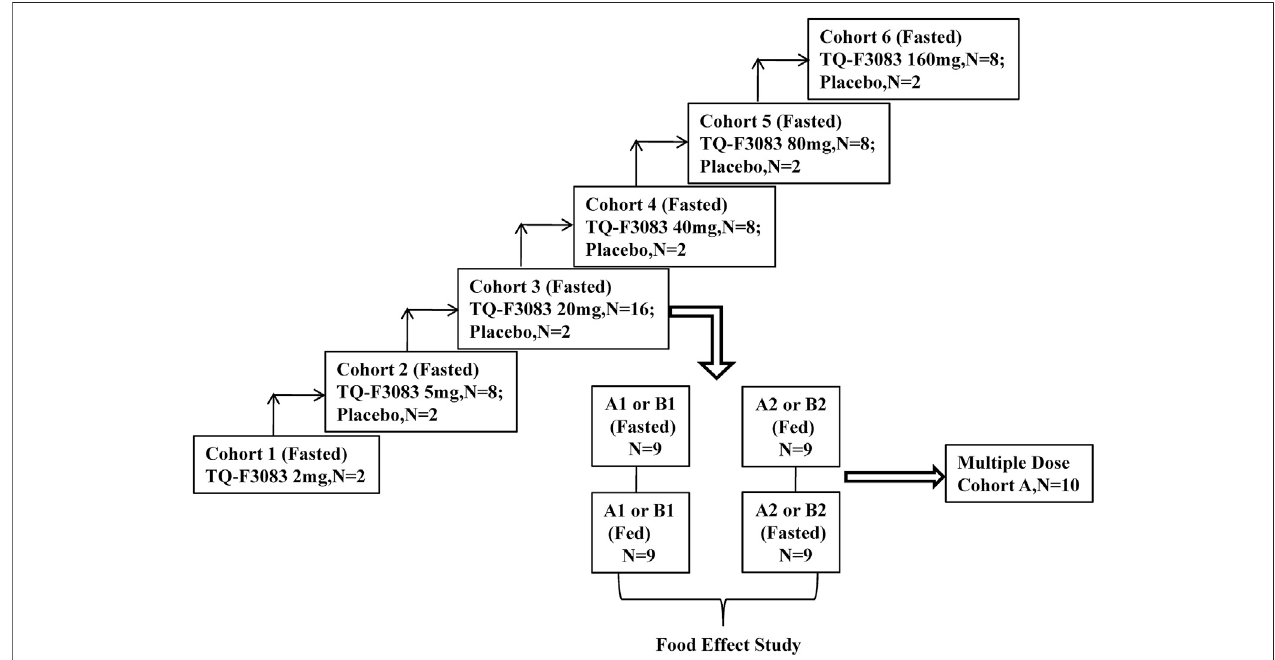
FIGURE 1 | Study fl